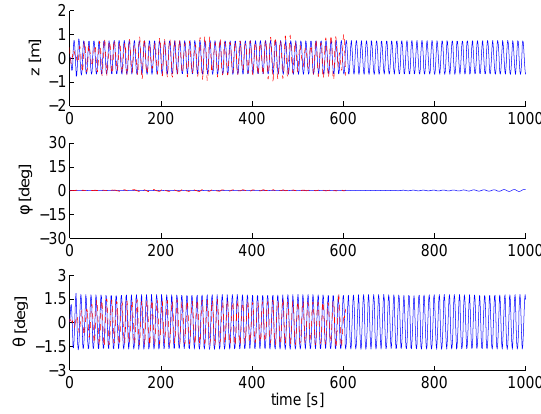
Figure 5: Exp. 1175. Exp. dashed red, sim. solid blue.